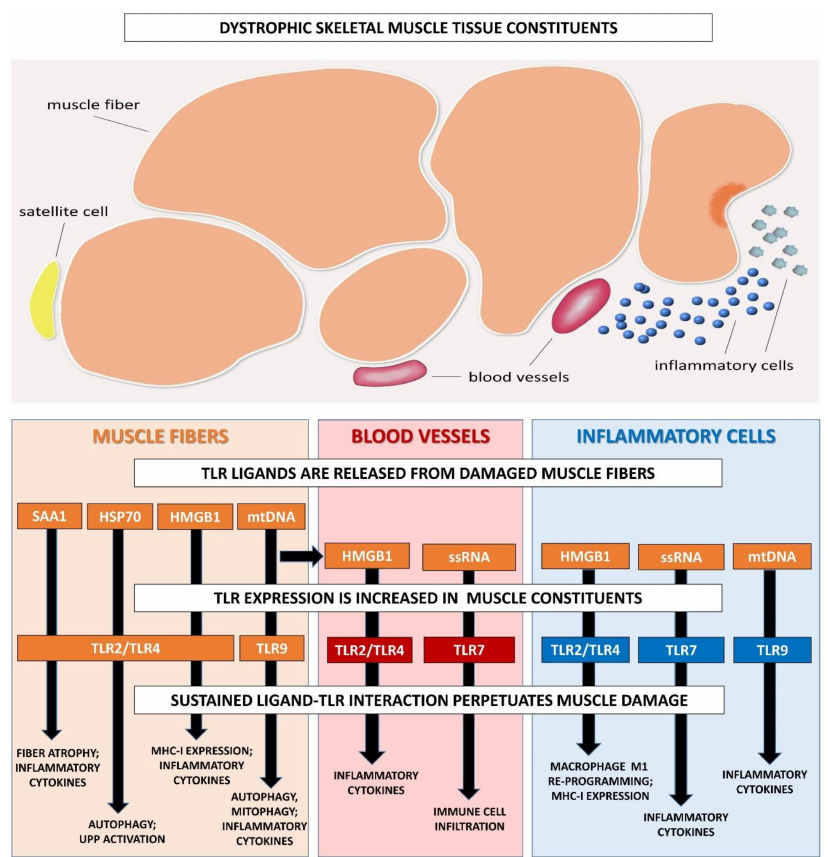
Figure 2. Model of TLR / ligand-driven tissue damage in muscular dystrophies. Proposed